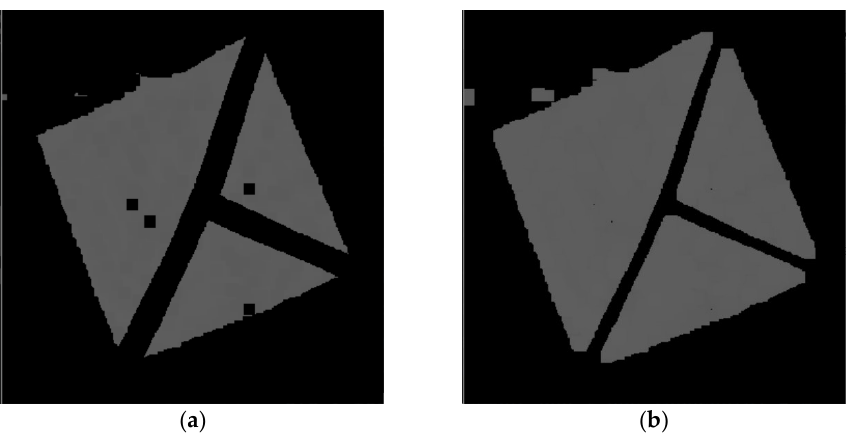
Figure 25. ( a ) image after performing erosion operation. ( b ) image after performing dilatation operation.